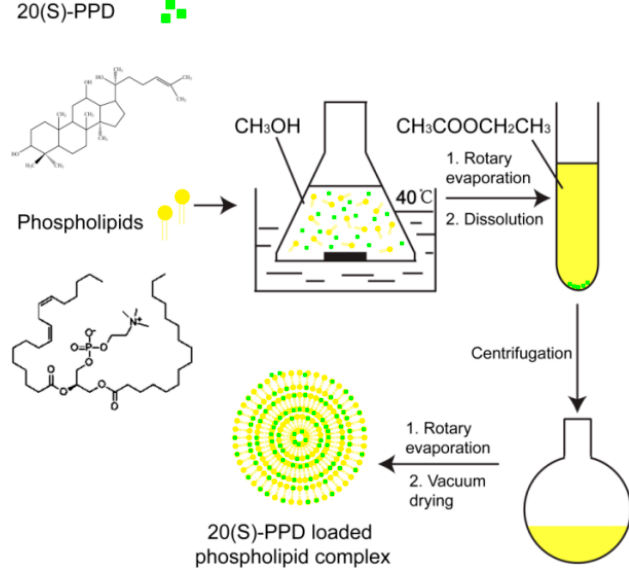
Figure 12. Scheme of the PPD-PLC preparation.